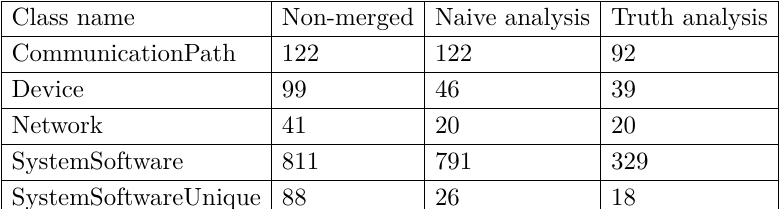
Table 9. Number of different model objects created using naive and truth analysis for the ArchiMate case